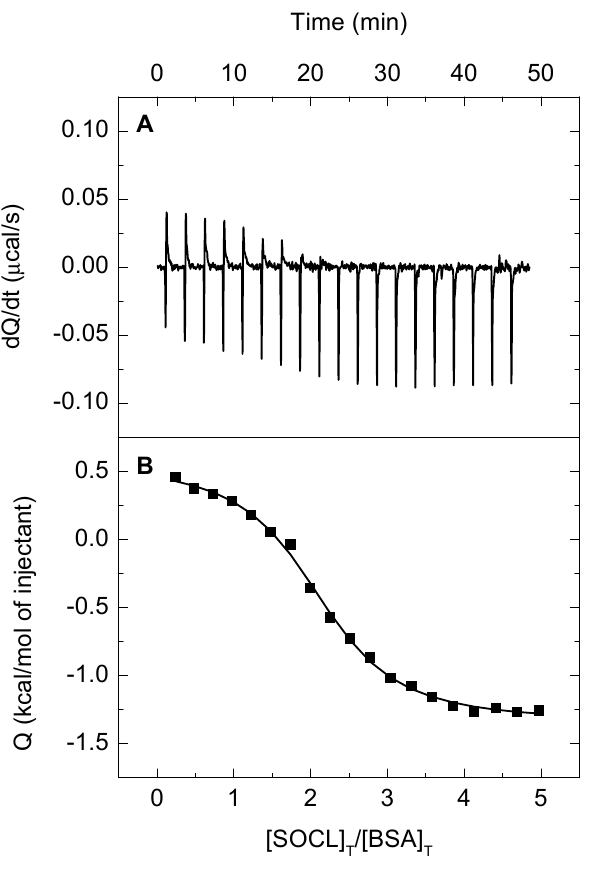
Figure6. Calorimetrictitrationofbovineserumalbumin(BSA)withSingletOxygenChemiluminescence probe (SOCL) in phosphate bu ff er saline pH 7.4. The upper panel ( A ) shows the heat e ff ects associated with the injection of SOCL (2 µ L per injection of a 300 µ M solution) into the calorimetric cell (200.7 µ L) Figure 6. Calorimetric titration of bovine serum albumin (BSA) with Singlet Oxygen containing monomeric BSA at a concentration of 12.5 µ M. The experiments were performed at 25 ◦ C. Chemiluminescence probe (SOCL) in phosphate buffer saline pH 7.4. The upper panel ( A ) shows the The lower panel ( B ) shows the binding isotherm corresponding to the data in the upper panel and the heat effects associated with the injection of SOCL (2 μ L per injection of a 300 μ M solution) into the best-fitted curve, considering a model for two identical and independent ligand binding sites in BSA calorimetric cell (200.7 μ L) containing monomeric BSA at a concentration of 12.5 μ M. The experiments (see the text for further were performed at 25 ° C. The lower panel ( B ) shows the binding isotherm corresponding to the data